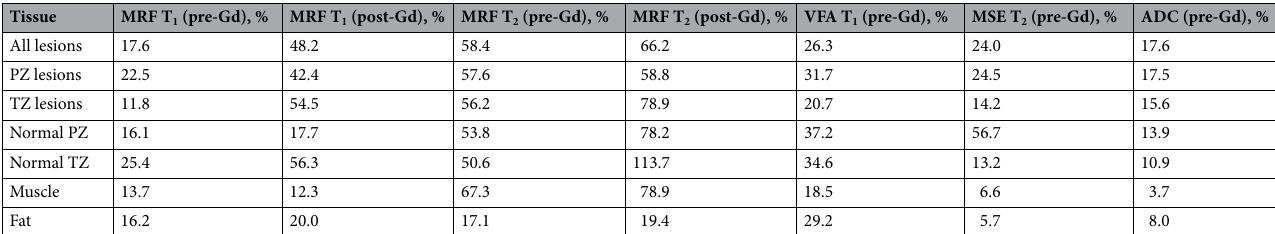
Table 2. Coefficients of variations of pre-contrast and post-contrast MRF T 1 and T 2 maps as well as pre- contrast VFA T peripheral zone, TZ transition zone.